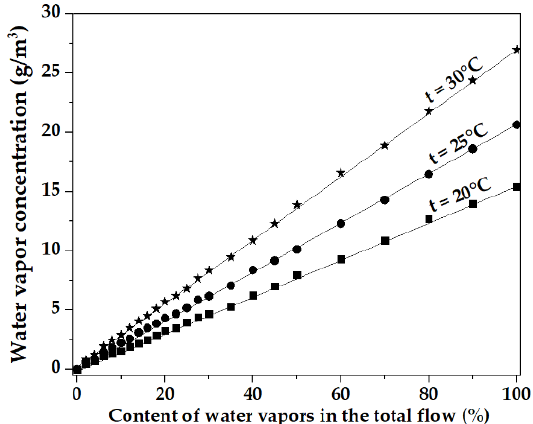
Figure 13. Dependencies of water vapor concentrations on their content in the measuring chamber at various ambient temperatures.